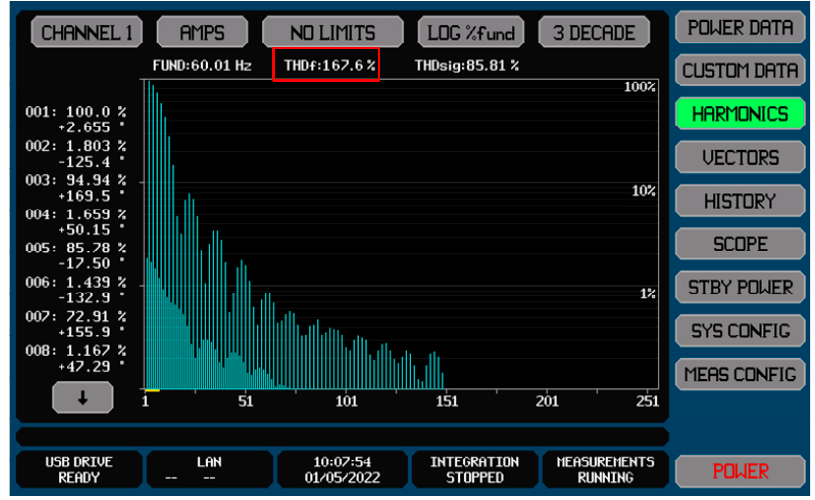
Figure 19. THD measured on the commercially available drive.